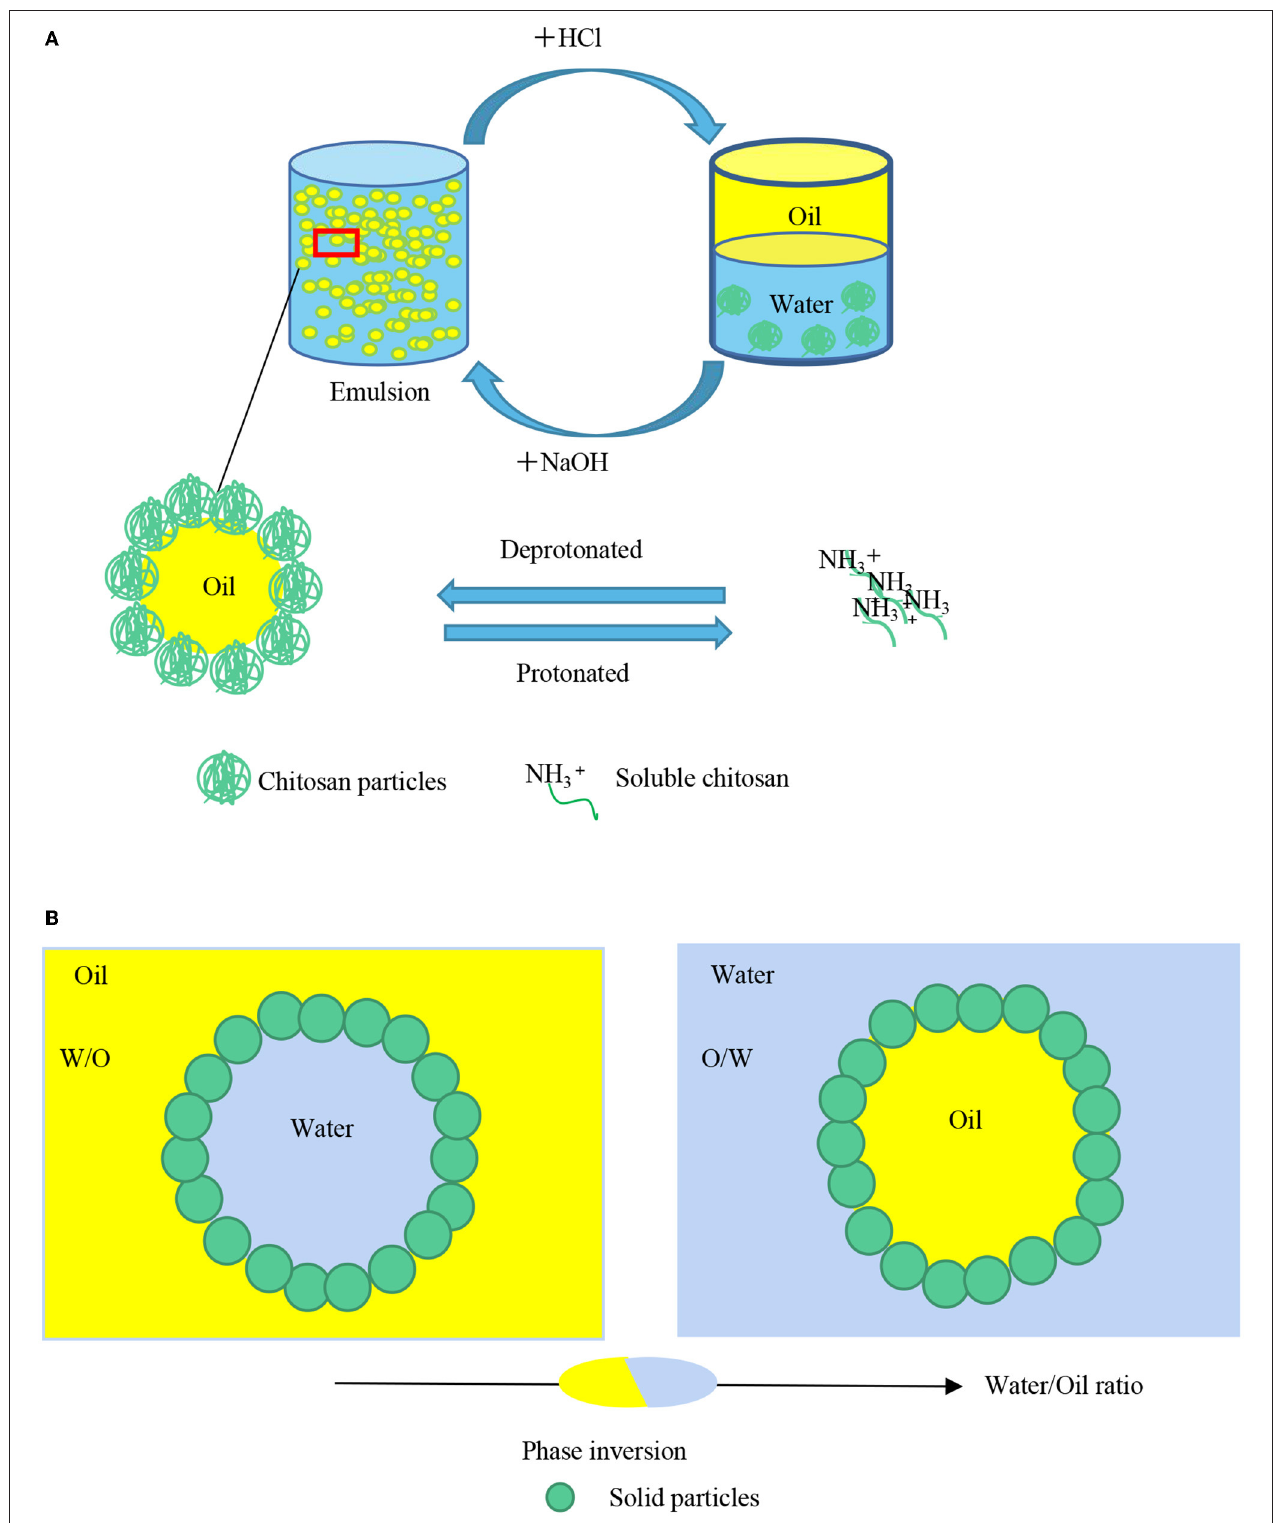
FIGURE 4 | (A) External factors affect the stability of Pickering emulsions pH affects the electrostatic interaction among solid particles, causing to regulate the adsorption behavior of solid particles. The emulsion droplets will exhibit dispersion or flocculation with the different adsorption behaviors. (B) Phase inversion will happen when the oil radio increase from 0.2 to